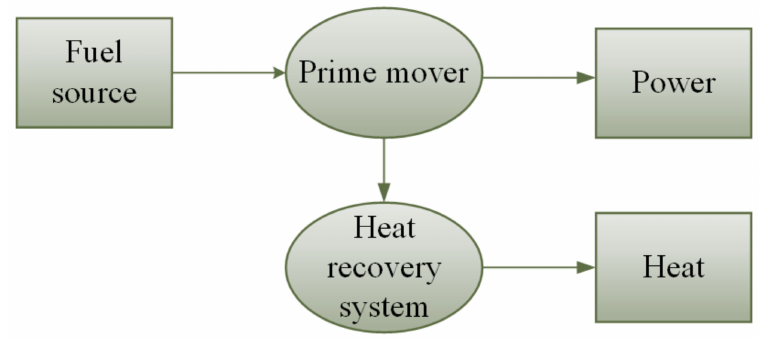
Figure 1. A schematic view of a simple cogeneration